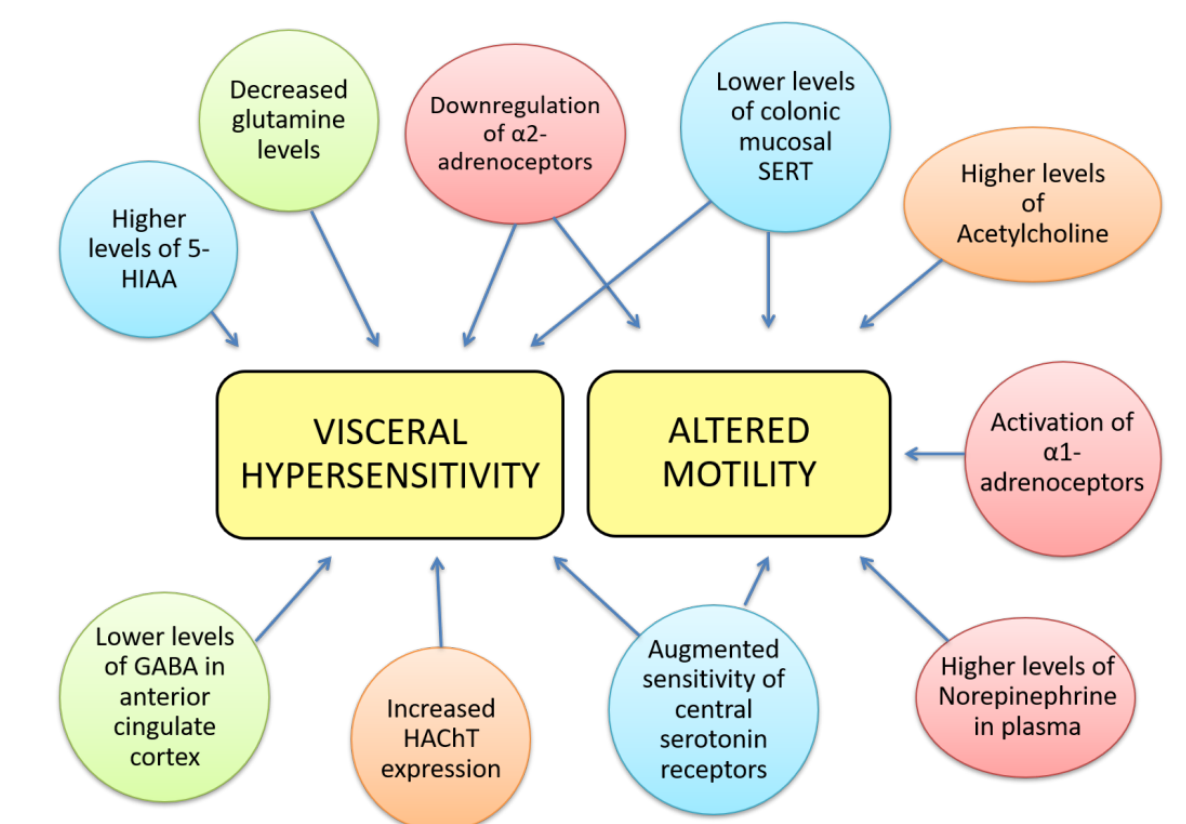
Figure 1. Neurotransmitter dysfunctions are related to some gastrointestinal IBS symptoms. Visceral hypersensitivity has been correlated to decreased glutamine levels, lower levels of GABA in the anterior cingulate cortex, higher levels of 5-hydroxy-indol acetic acid, increased expression of high affinity choline transporter, downregulation of α -2 adrenoceptors, augmented sensitivity of central serotonin receptors and lower levels of mucosal SERT. The latter 3 alterations can also be found in altered colorectal motility together with higher levels of NE in plasma, activation of α -1 adrenoceptors and higher levels of ACh. We notate neurotransmitter’s families with colours: red- norepinephrine; blue- 5-HT; green- GABA; orange-acetylcholinergic.